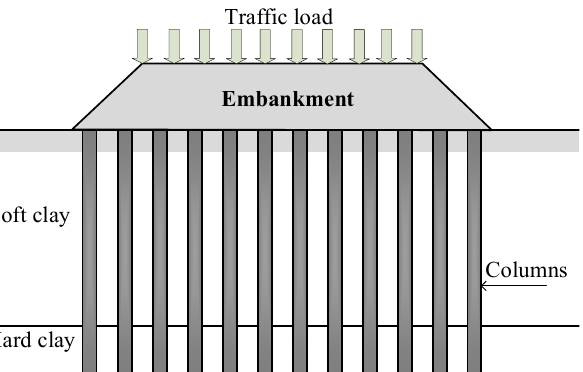
Figure 1. A typical cross-section of column-supported highway and railway embankments on a soft clay foundation.